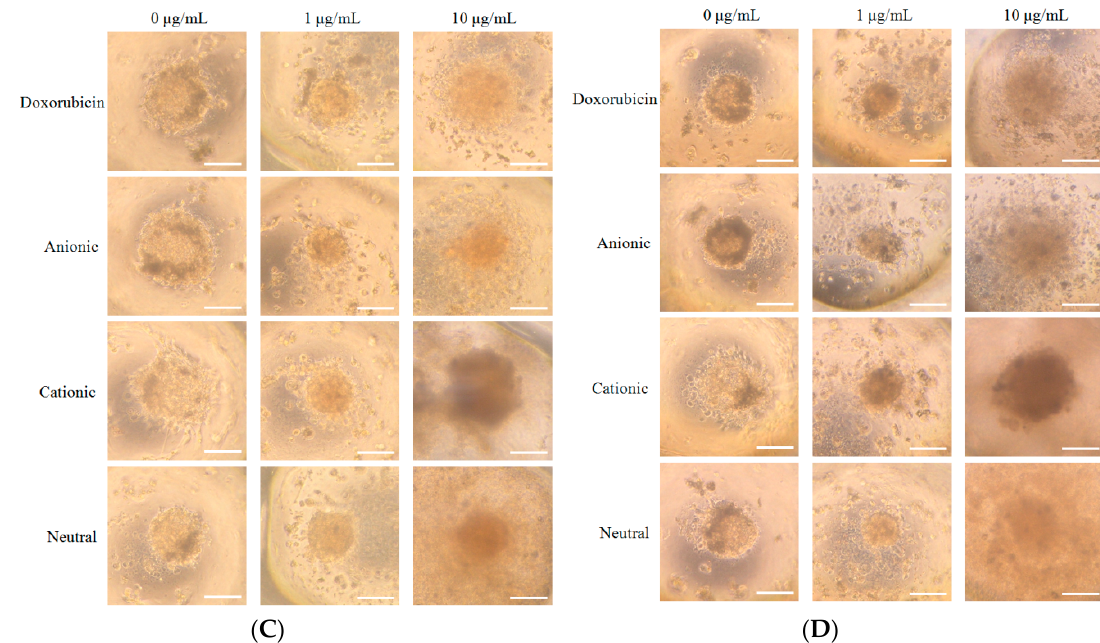
Figure 2. ( A ) Morphology of the cell spheroids cultured in osteogenic media on Day 1 (original magnification ×200). The scale bar indicates 100 μ m. ( B ) . Morphology of the cell spheroids cultured in osteogenic media on Day 3 (original magnification ×200). The scale bar indicates 100 μ m. ( C ) Morphology of the cell spheroids cultured in osteogenic media on Day 5 (original magnification ×200). The scale bar indicates 100 μ m. ( D ) Morphology of the cell spheroids cultured in osteogenic media on Day 7 (original magnification ×200). The scale bar indicates 100 μ m. Table 1. The cellular viability of stem cell spheroids on Days 1, 3, 5, and 7. Groups ( n = 3) p - Day